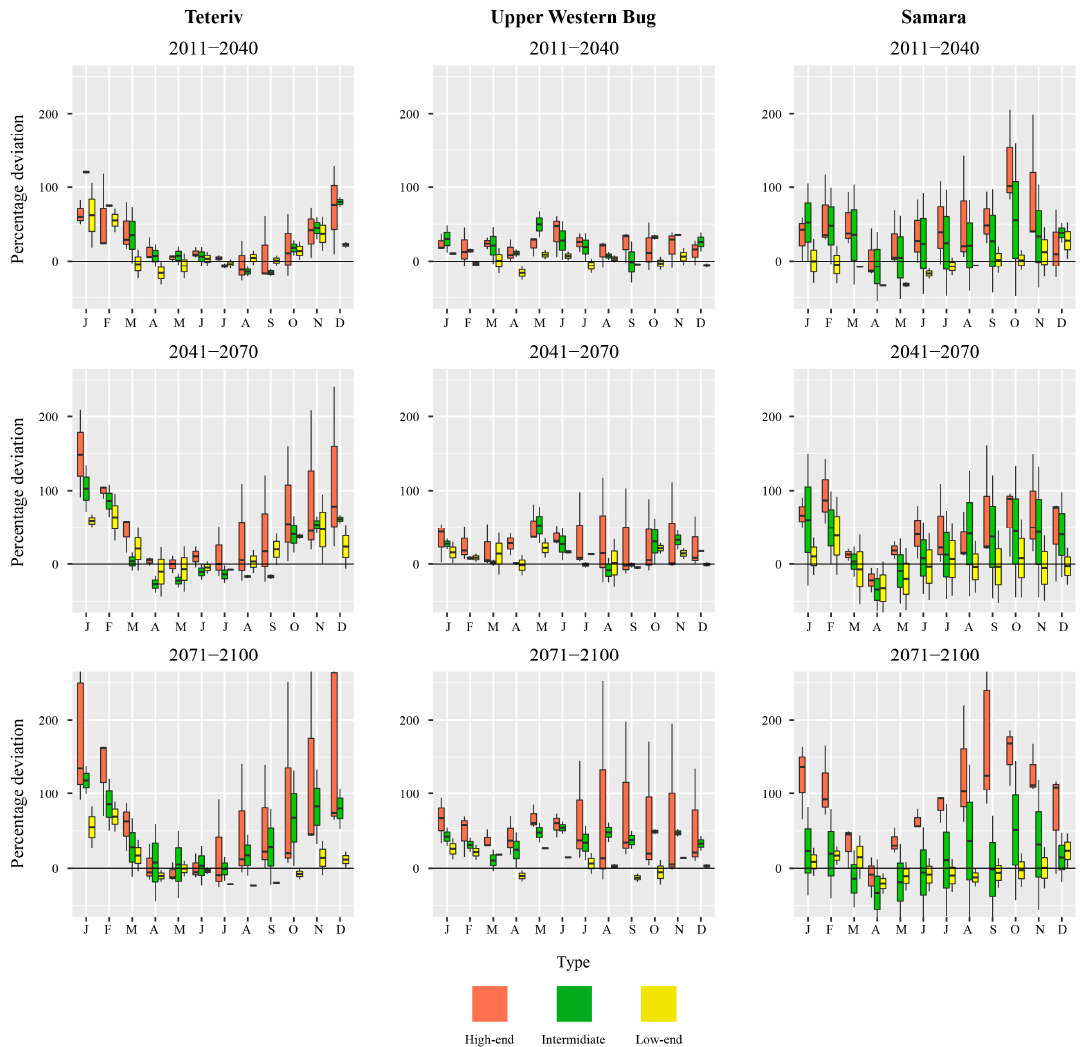
Figure 4. The projected future changes in areal catchment mean of river discharge in the basins under consideration for three scenarios and three future periods compared to the reference period shown as boxplots, where the boxes show ranges between the 25th and 75th percentiles, and thick black lines show the median values.